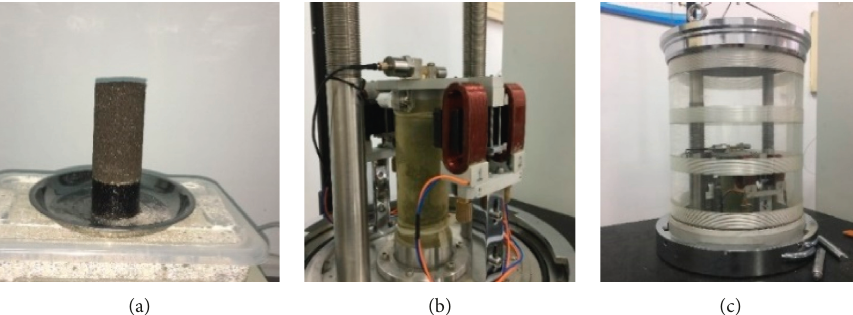
Figure 4: Test sample in the resonant column apparatus: (a) formed sample; (b) loading sample; (c) sample covered with the pressure chamber.